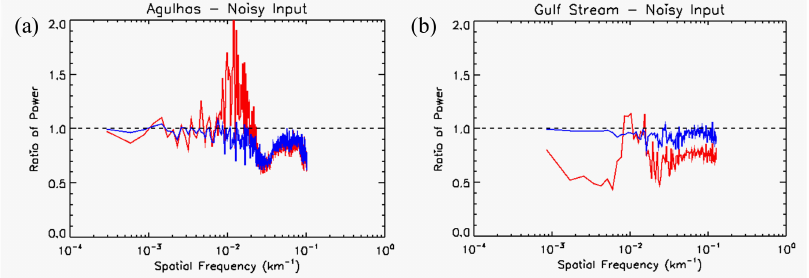
Figure 11. Comparison of the power spectra of the SST field in January from IR-only analysis (red) and combined IR and MW analysis (blue) where both contain realistic input errors. The data are plotted as a ratio to the “truth” SST power spectrum at each wavelength: ( a ) Aghulas Current region and ( b ) Gulf Stream